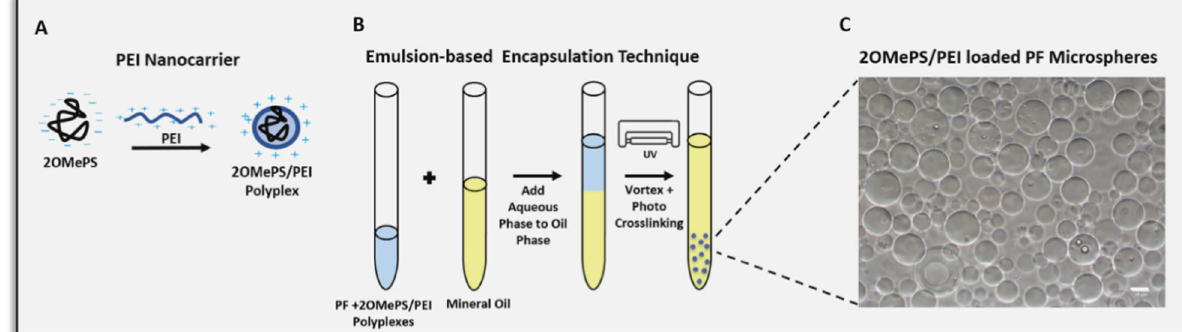
Fig. 1 PF microspheres made with an emulsion-based technique for 2OMePS AON encapsulation. A The 2OMePS AONs were complexed with a transfection carrier, PEI, to form nano-scaled polyplexes. B The resultant polyplexes were encapsulated using a dual photo-initiator emulsion-based technique to form AON-laden PEG- fi brinogen (PF) microspheres . C A representative light microscopy image of PF microspheres, (scale bar = 50